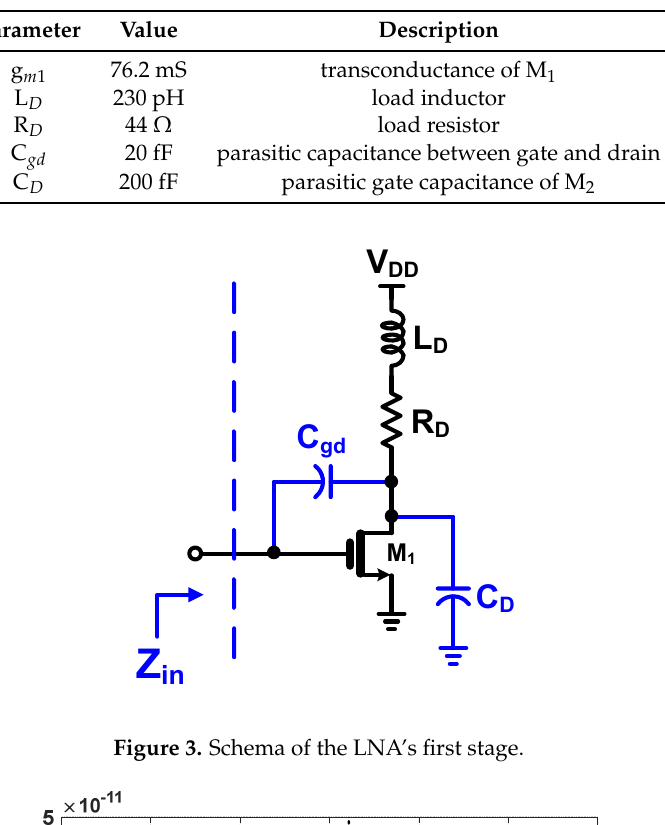
Table 1. LNA design parameters.